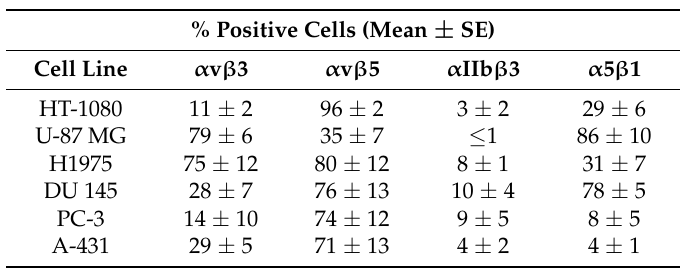
Table 1. Expression of α v β 3, α v β 5, α IIb β 3 and α 5 β 1 integrins in a panel of cultured tumor cell lines as determined by flow cytometry analysis. % Positive Cells (Mean ±